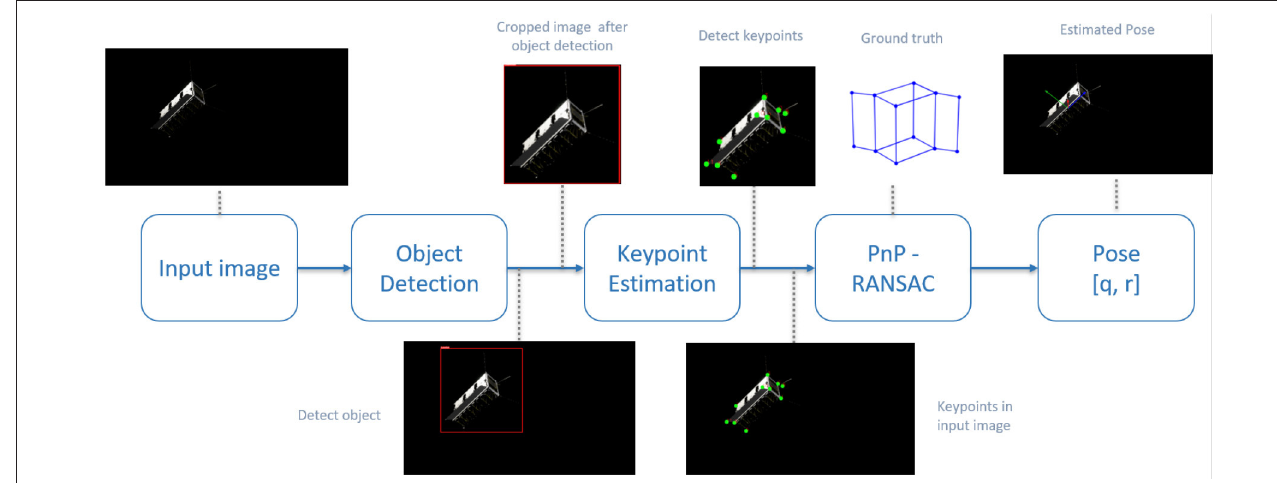
FIGURE 5 | Sample photo-realistic visuals of CubeSat model in orbit generated using the OrViS